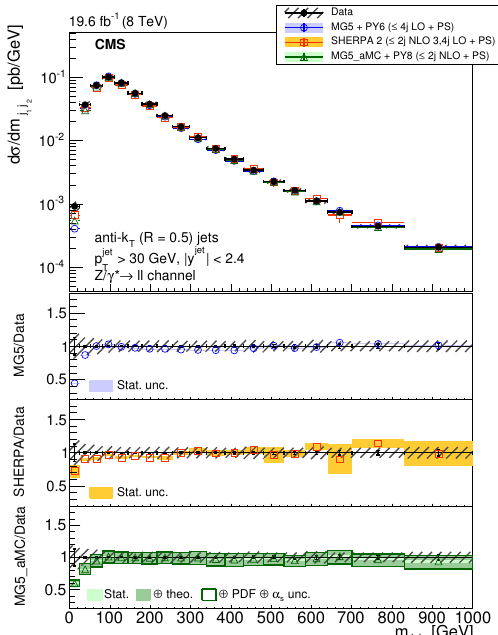
Figure 28 . The di(cid:11)erential cross section for Z ( ! ‘‘ ) + jets production as a function of the dijet invariant mass for N jets (cid:21) 2 compared to the predictions calculated with MadGraph 5 + pythia 6, sherpa 2, and mg5 a mc + pythia 8. The lower panels show the ratios of the theoretical predictions to the measurements. Error bars around the experimental points show the statistical uncertainty, while the cross-hatched bands indicate the statistical and systematic uncertainties added in quadrature. The boxes around the mg5 a mc + pythia 8 to measurement ratio represent the uncertainty on the prediction, including statistical, theoretical (from scale variations), and PDF uncertainties. The dark green area represents the statistical and theoretical uncertainties only, while the light green area represents the statistical uncertainty